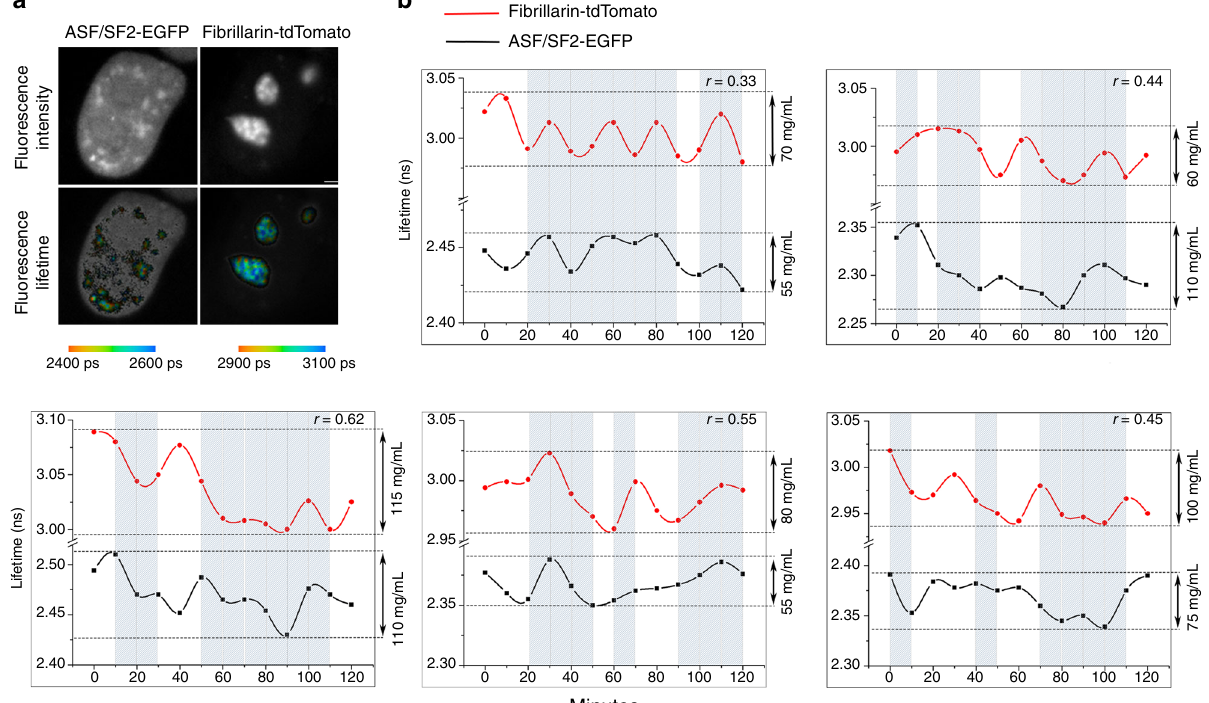
Fig. 4 Correlation of protein concentration changes in nucleoli and nuclear speckles. Cells expressing Fibrillarin-tdTomato and ASF/SF2 – EGFP were used for simultaneous fl uorescence lifetime imaging (FLIM) imaging of the nucleoli and the nuclear speckles. a Fluorescence intensity and fl uorescence lifetime images of ASF/SF2-EGFP and tdTomato in the same cell. Scale bar is 1 μ m. b Fluorescence lifetimes for Fibrillarin-tdTomato and ASF/SF2-EGFP were monitored for same cells and shown on the left y -axis. Corresponding calculated ranges of protein concentrations are shown on the right y -axis. Synchronized for both organelles changes in lifetime/concentration are marked by shaded boxes. Pearson correlation coef fi cients ( r ) between the fl uctuations of the protein concentrations in both organelles for each cellular data set are 0.33, 0.44, 0.62, 0.55, and 0.45, as